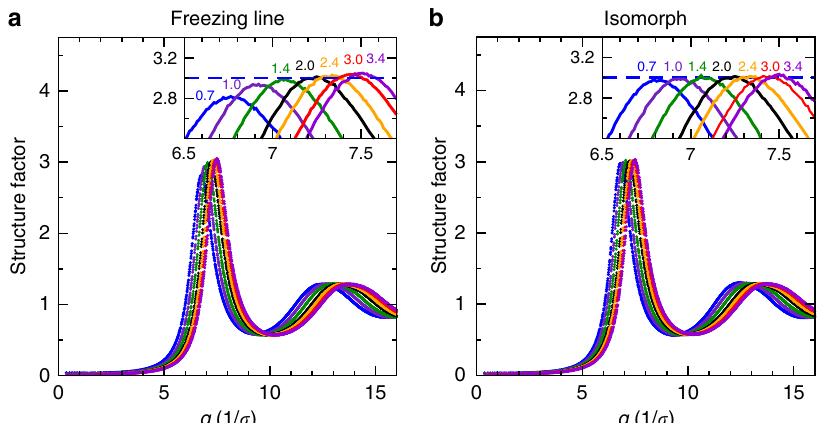
Figure 1 | Structure of the LJ liquid. ( a ) Liquid structure factor along the freezing line 37 showing results from T ¼ 0.7 e / k B , which is close to the triple point, to T ¼ 3.4 e / k B . The hard-sphere model predicts that the height of the first peak is invariant along the freezing line as indicated by the blue dashed line in the inset. Small, but systematic deviations are observed. ( b ) Liquid structure factor along the isomorph crossing the freezing line at temperature T 0 ¼ 2.0 e / k B (henceforth used as the liquid reference isomorph), demonstrating structural invariance to a much higher degree. This is the basis for the theory proposed in the present